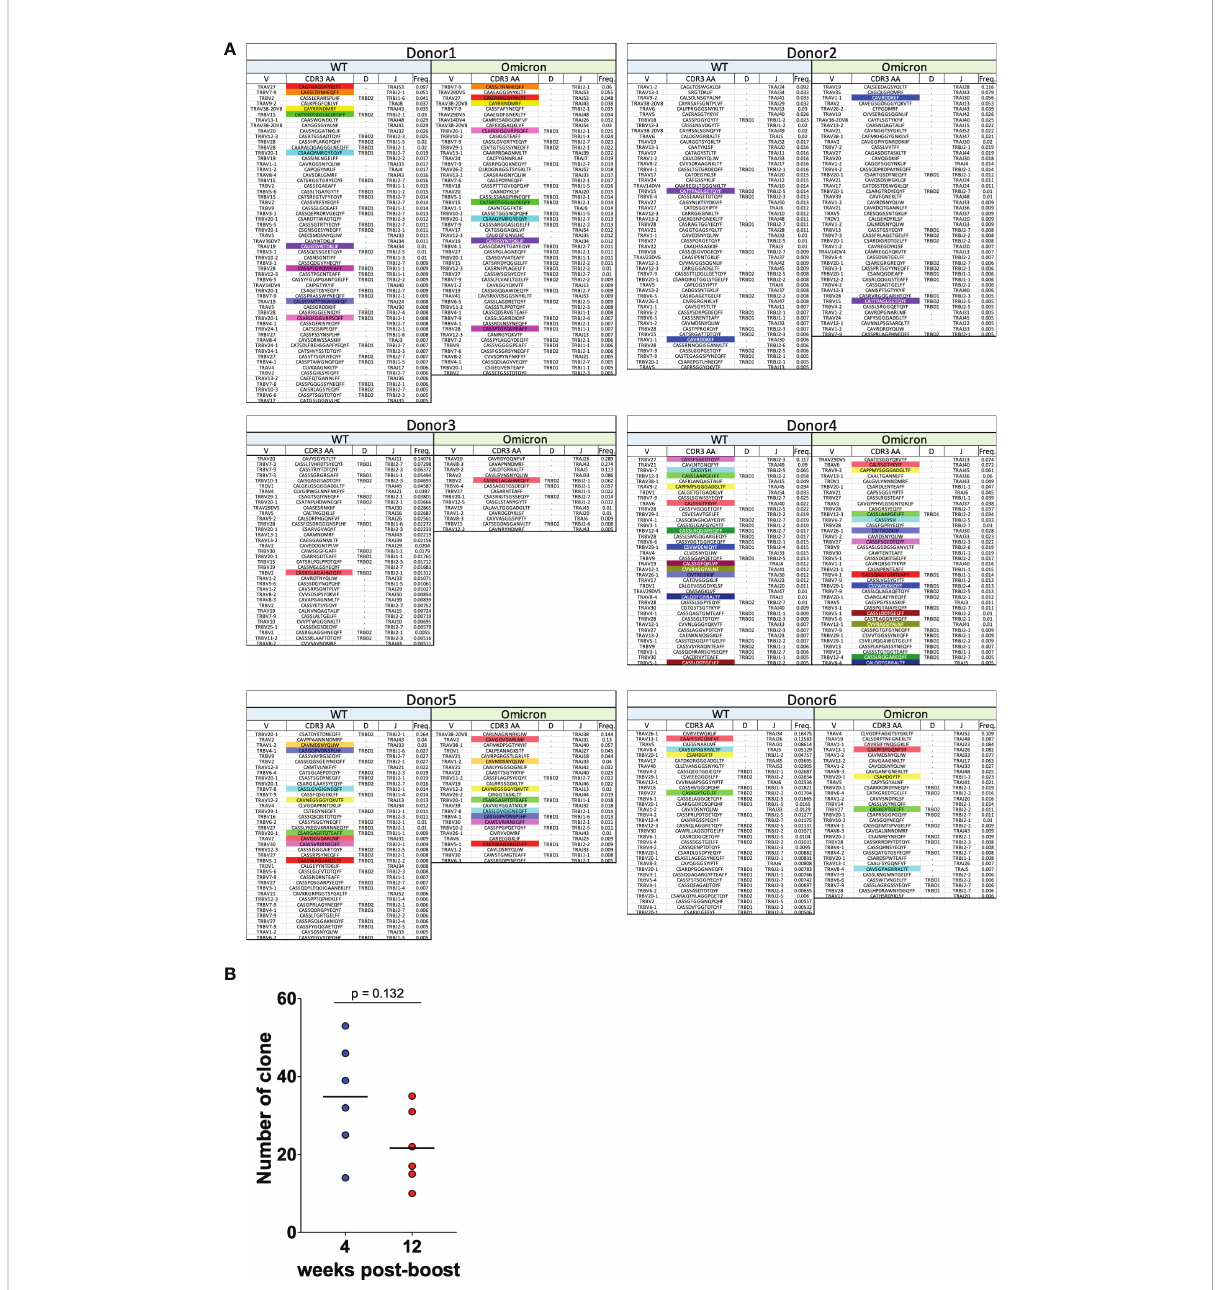
FIGURE 4 CD8 + T cells induced by mRNA vaccines are cross-reactive to Omicron strains. (A) TRAV, TRAJ, TRBV, TRBD, and TRBJ usage, CDR3 amino acid sequence, and the relative frequencies of CD8 + T cell clonotypes speci fi c for the SARS-CoV-2 spike WT and Omicron are shown for six vaccinated donors at 4 weeks after the second vaccination. Colored boxes indicate CDR3 amino acid sequence reactive in common to WT and Omicron. (B) Dot plots representing the number of TCR clones against Omicron